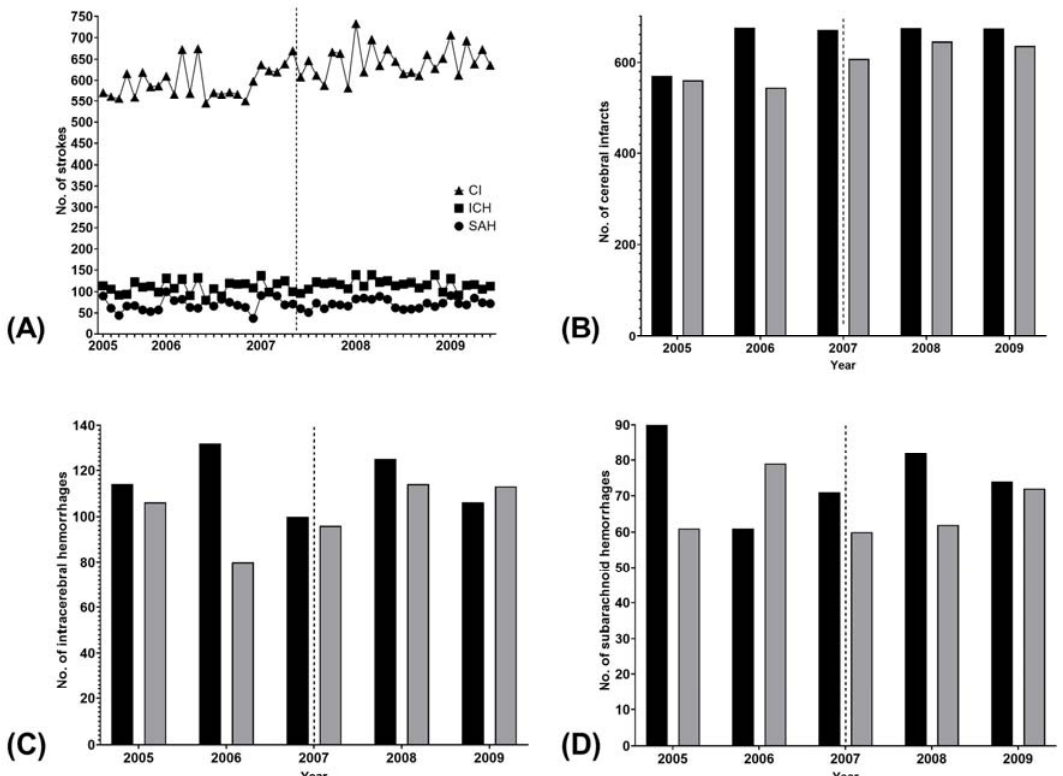
Figure 1. Number (N) of stroke admissions by stroke type. ( A ) All admissions from May 2005 to June 2009; ( B ) May and June admissions for cerebral infarction; ( C ) May and June admissions for intracerebral hemorrhage; ( D ) May and June admissions for subarachnoid hemorrhage. The dashed line marks the introduction of the nationwide restaurant smoking ban on 1 June 2007. CI, cerebral infarction; ICH, intracerebral hemorrhage; SAH, subarachnoid hemorrhage. Black bars, May; grey bars, June.